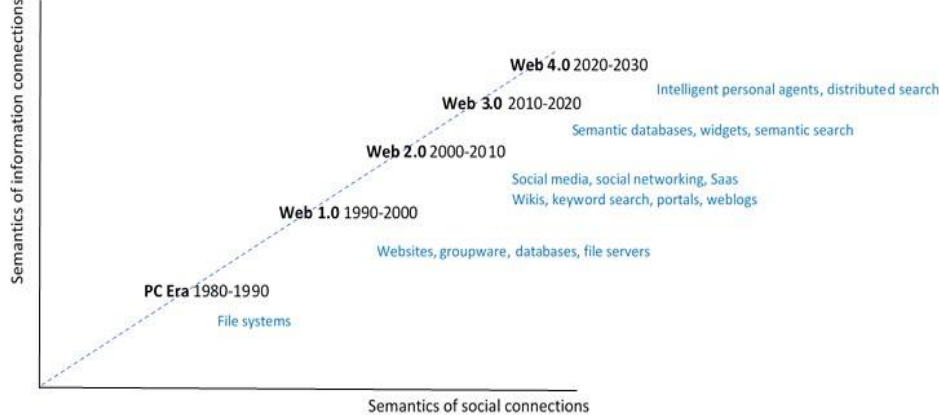
Figure 2. Advances in web technologies (http://ahmadfaizar.blogspot.com/2018/08/evolution-of- web-web-10-web-20-web-30.html), accessed on 17 May 2020.